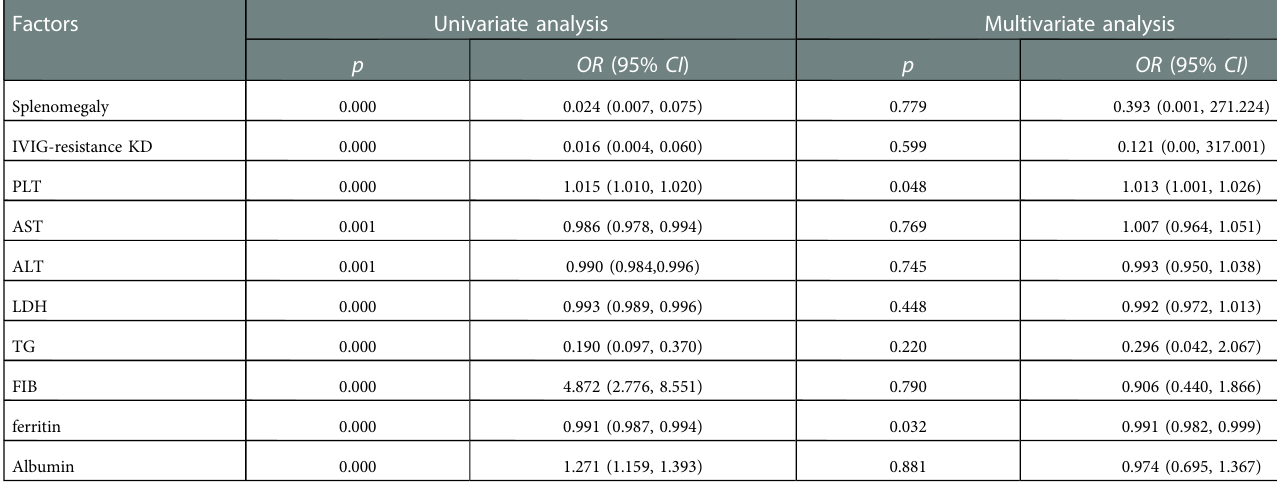
TABLE 2 Logistic regression analysis of early predictive factors for KD to develop MAS.